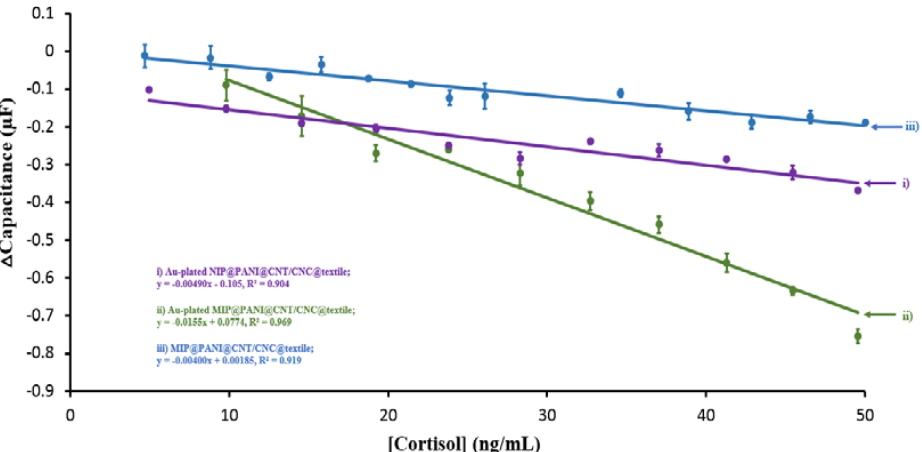
Figure 6. Linear calibration plots for Δcapacitance signal as function of cortisol concentration for (i)